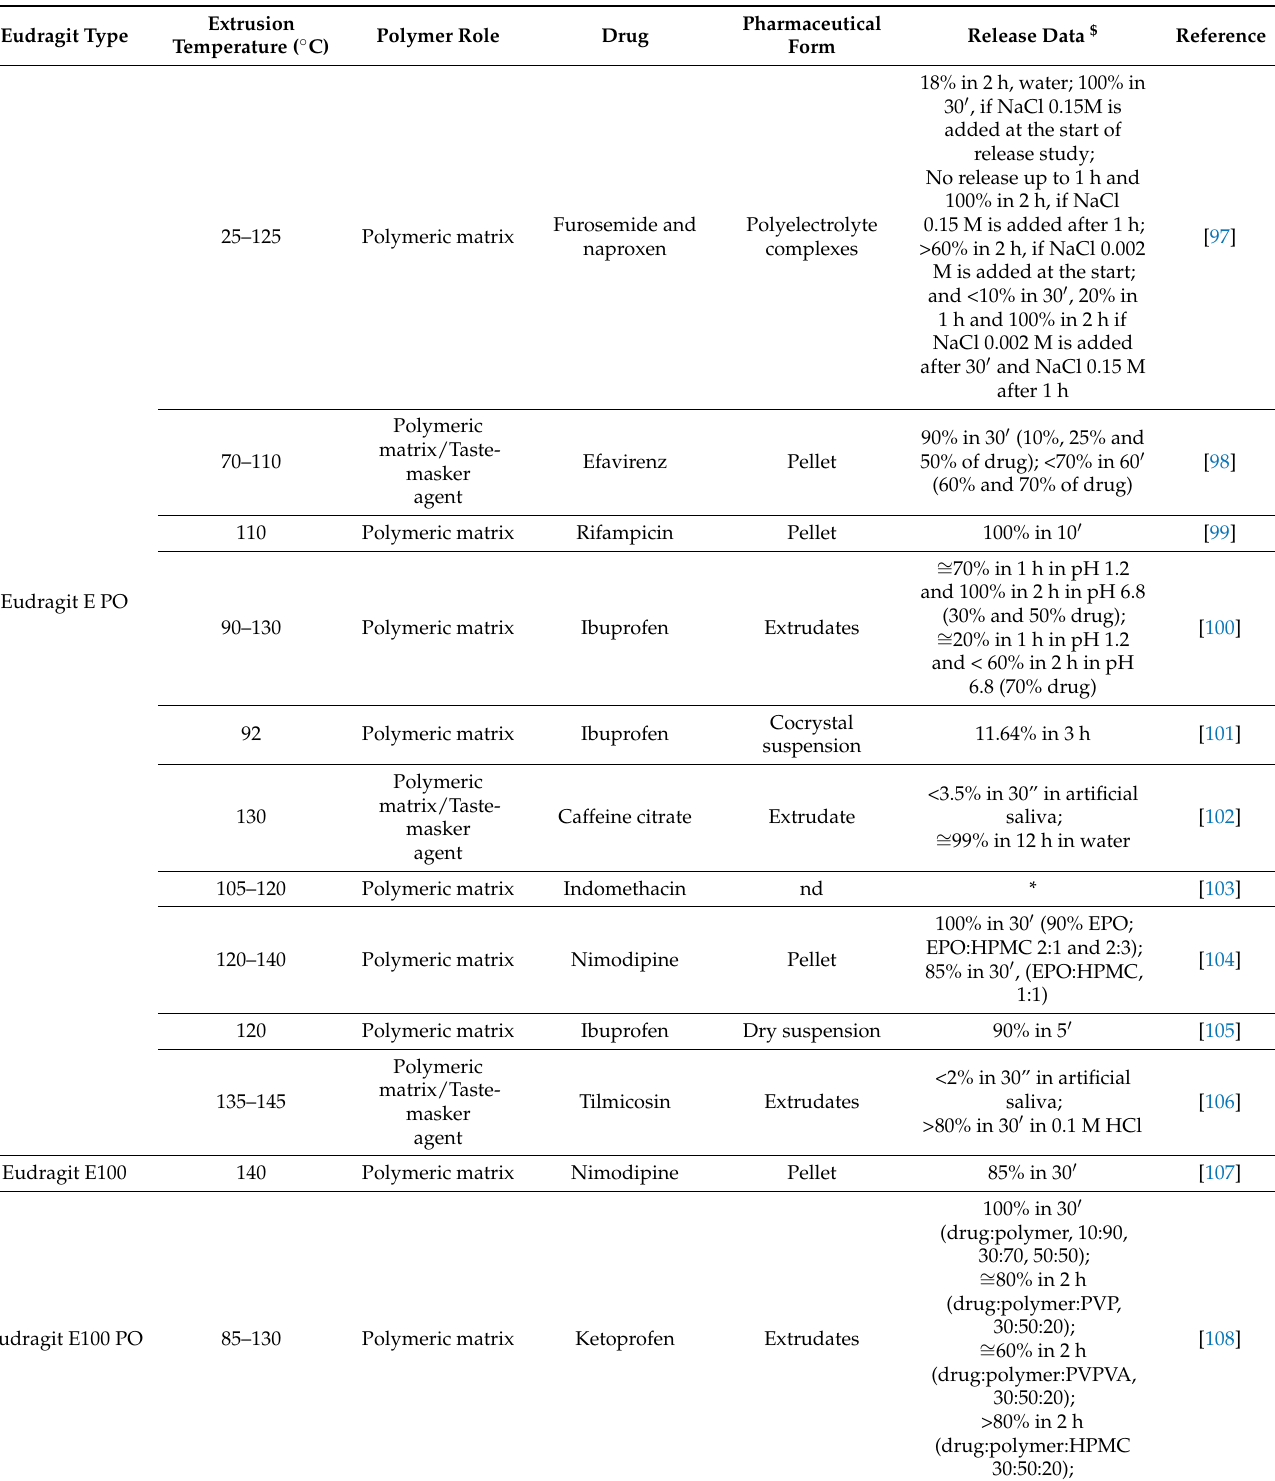
Table 4. Other formulations produced by HME using Eudragit